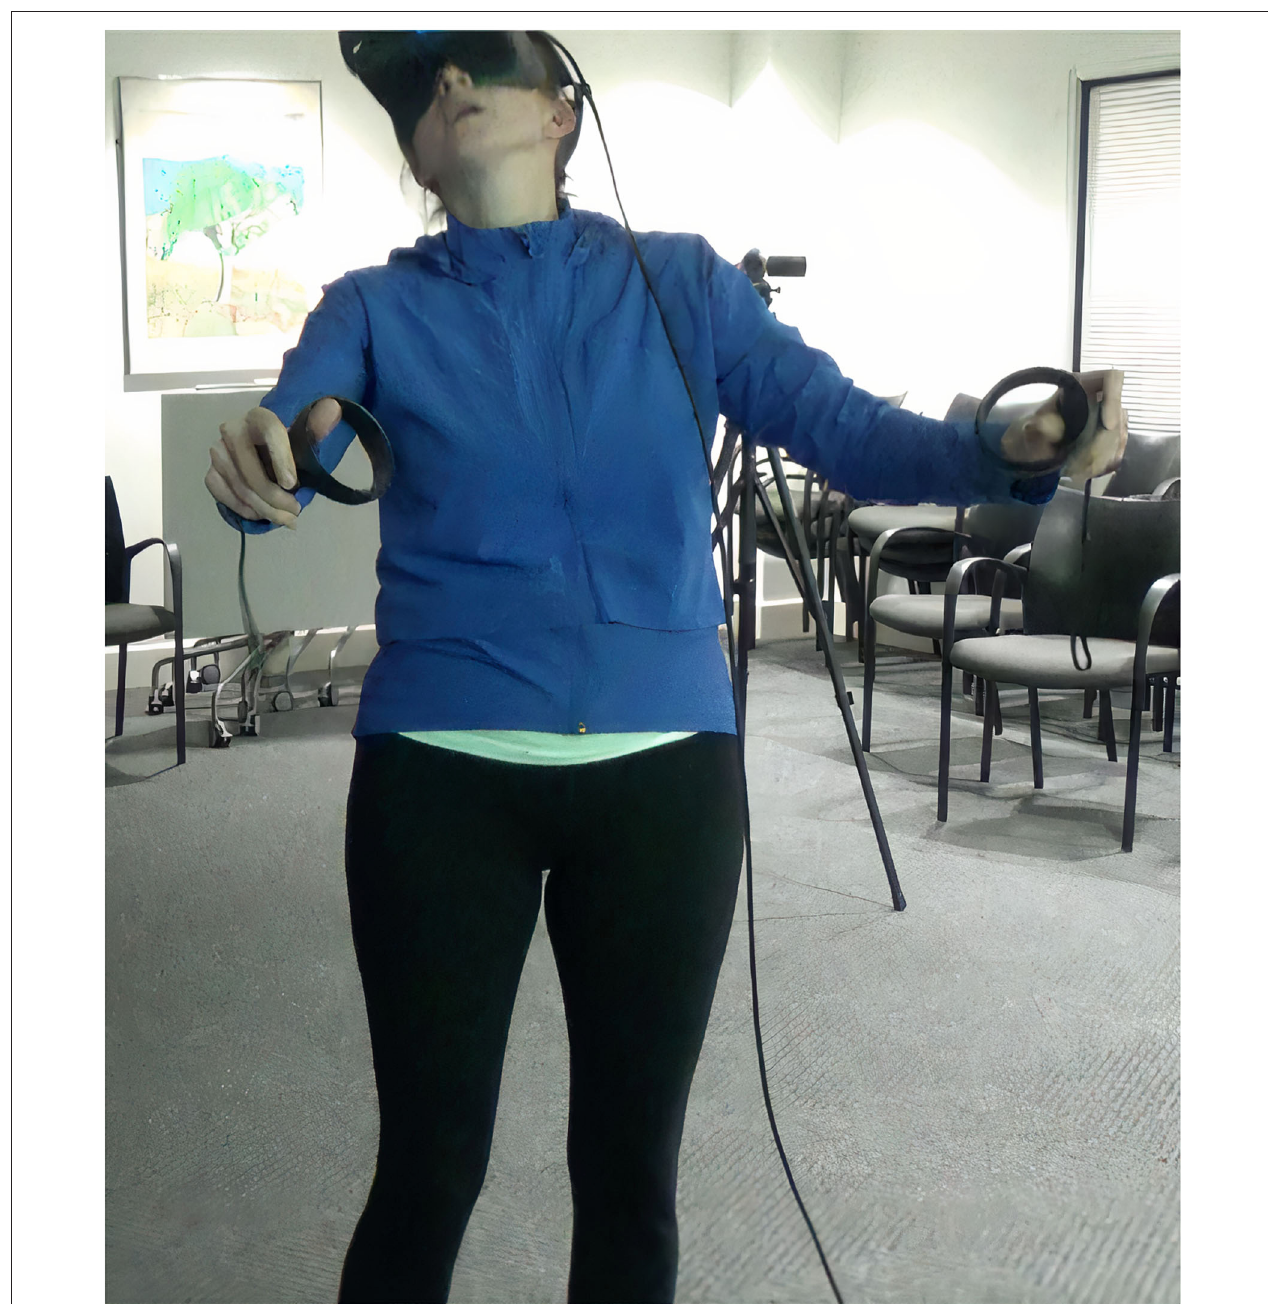
FIGURE 5 | Feet planted firmly as upper body leans as she moves upper body away from the animated dinosaur.